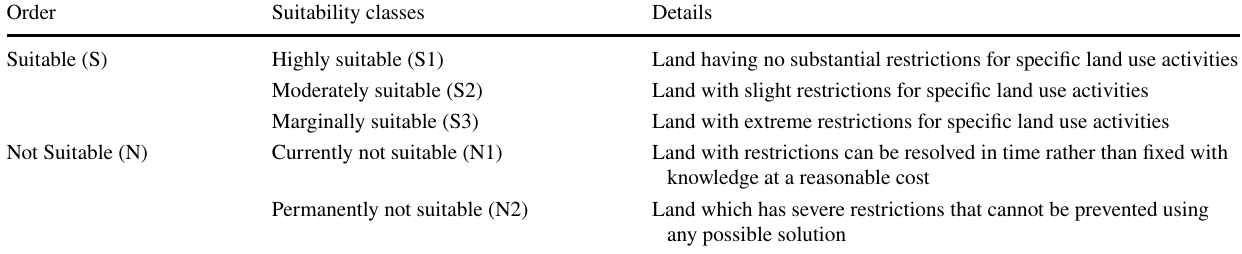
Table 2 Land suitability classification (FAO,